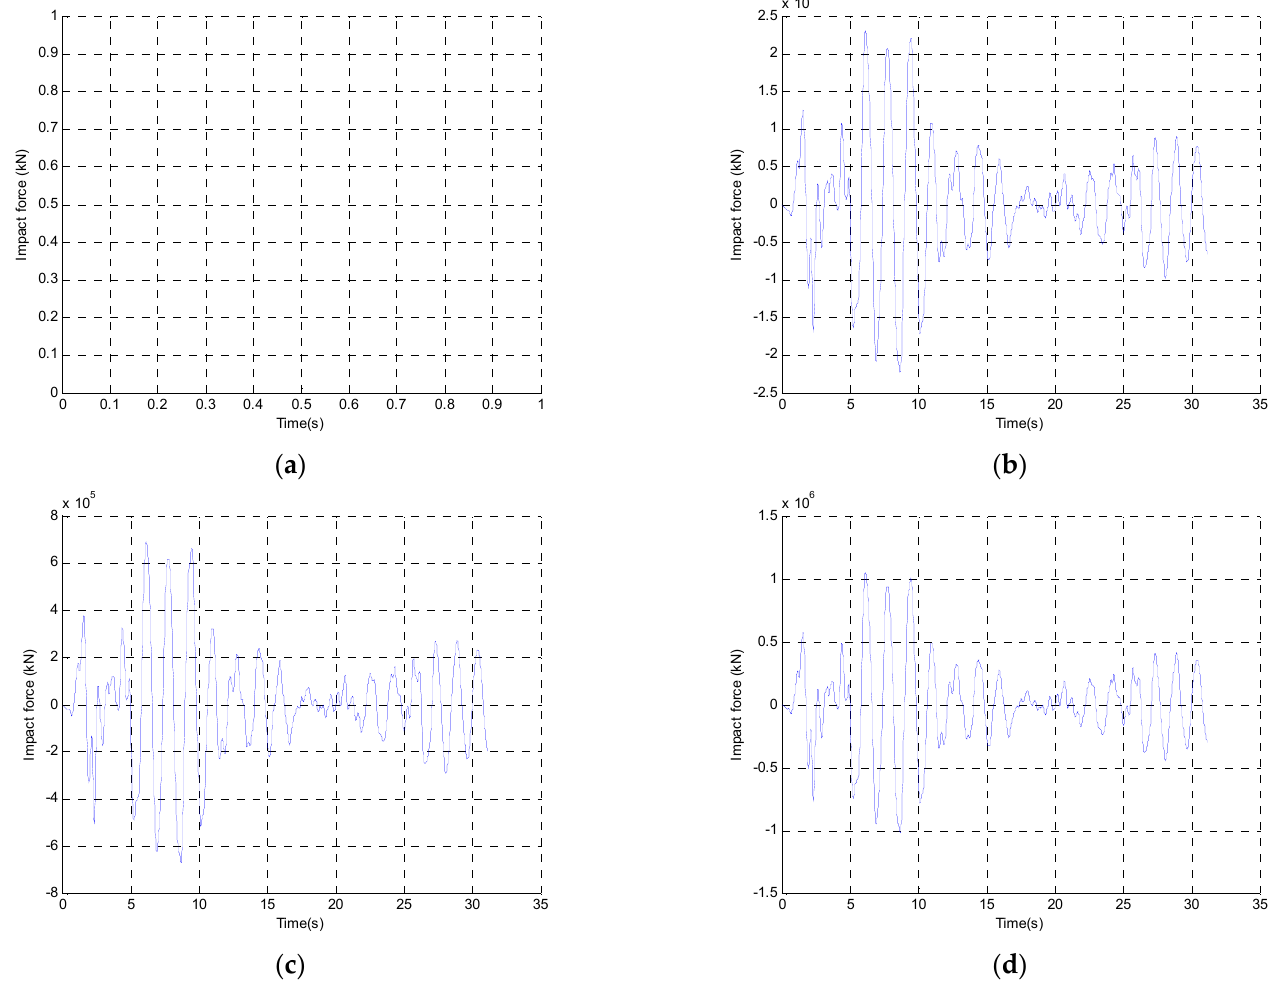
Figure 9. Impact force time histories obtained for each story: ( a ) base level; ( b ) first story; ( c ) second story; ( d ) third story.